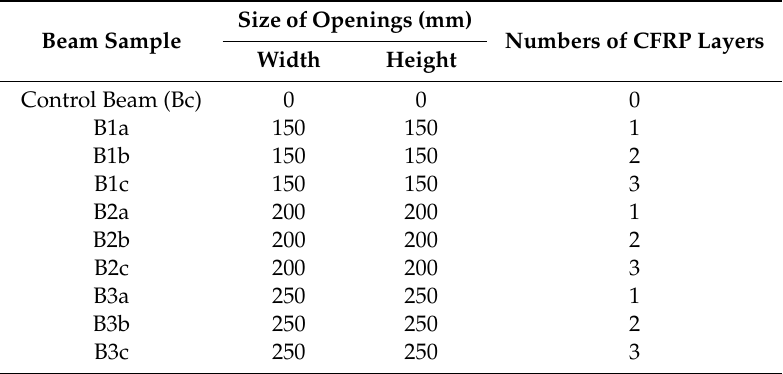
Table 1. Beam specimen